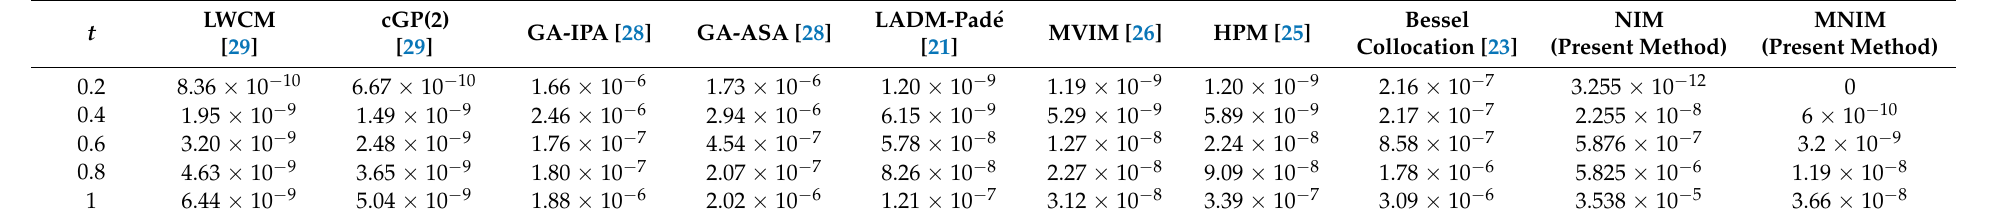
Table 3. Comparison of Absolute Errors for Y ( t ) of MNIM Scheme and LWCM, cGP(2), GA-IPA, GA-ASA, LADM-Pad é , MVIM, HPM, Bessel collocation, NIM relative to RK4 Method for HIV Infection Model.